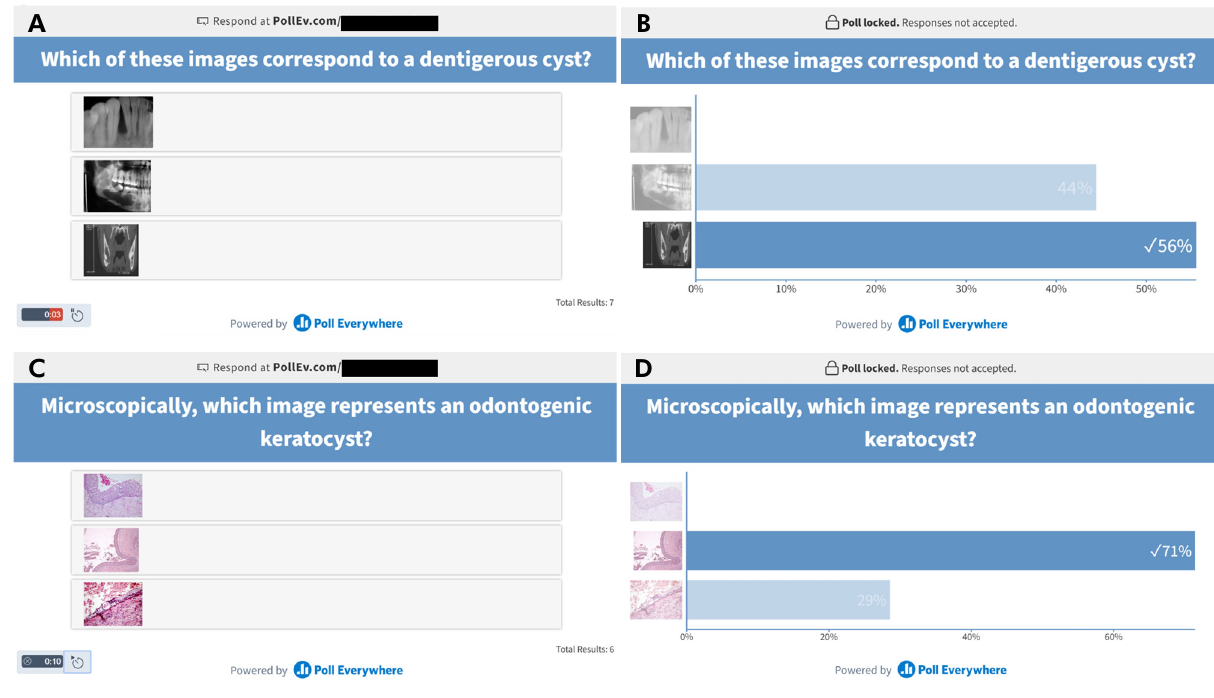
Figure 1. A, C - Examples of how questions are presented in PowerPoint during class using Poll Everywhere. B, D - After the students’ answers, percentage of responses for each alternative represented in graphs and presented in